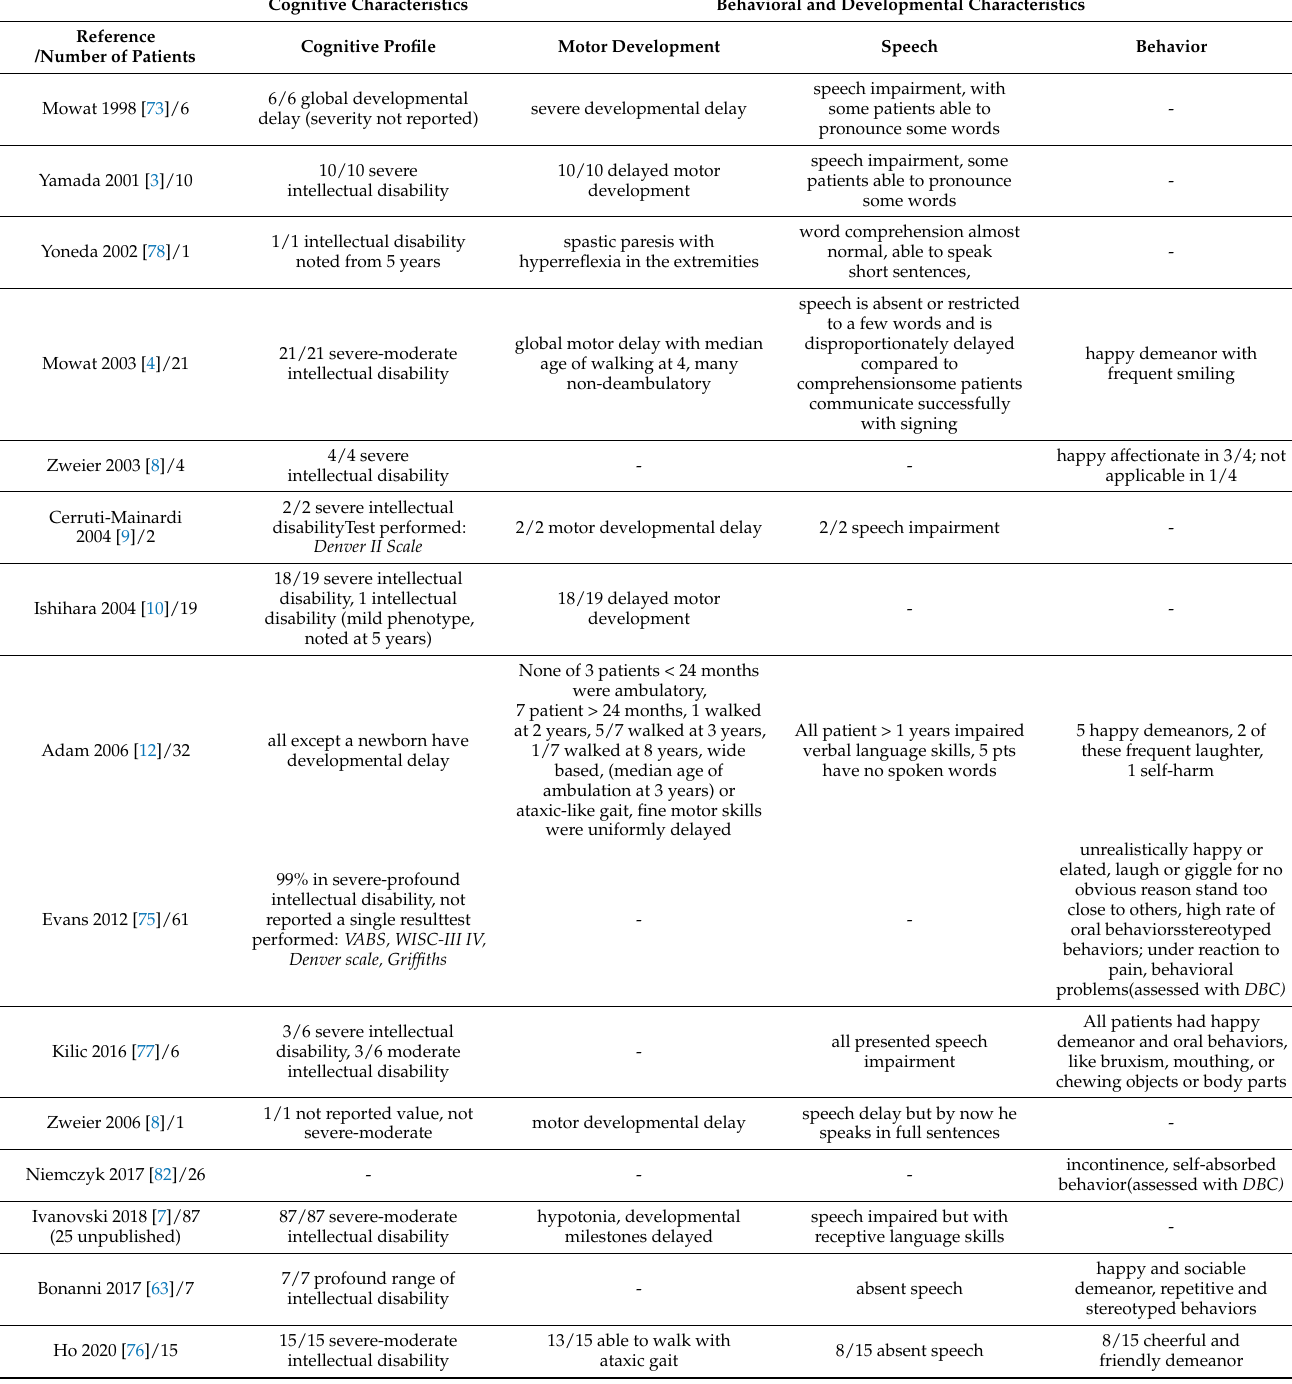
Table 2. Cognitive, developmental, and behavioral features in Mowat-Wilson